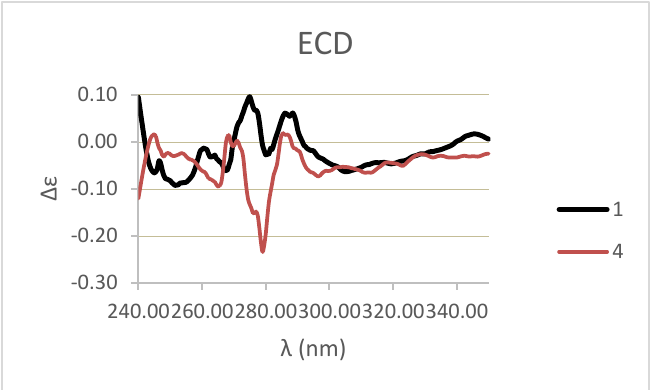
B Figure 2. ( A ) ORTEP view of the homoisoflavanoid ( 1 ) molecular structure, with ellipsoids drawn at the 30% probability level. ( B ) Independent unit of compound 1 in a perspective view showing a quite parallelism between hydroxybenzene plane (green) and benzene ring of chromanone system (orange) (angle of 7.55° between the two planes). Ball-and-stick style. Hydrogen bonds drawn as cyan and red dashed lines. A B Figure 3. ( A ) Details of hydrogen bonding pattern in compound 1 . ( B ) Perspective view of the crystal packing of compound 1 with hydrogen bond pattern drawn as cyan and red lines. Ball-and-stick style.